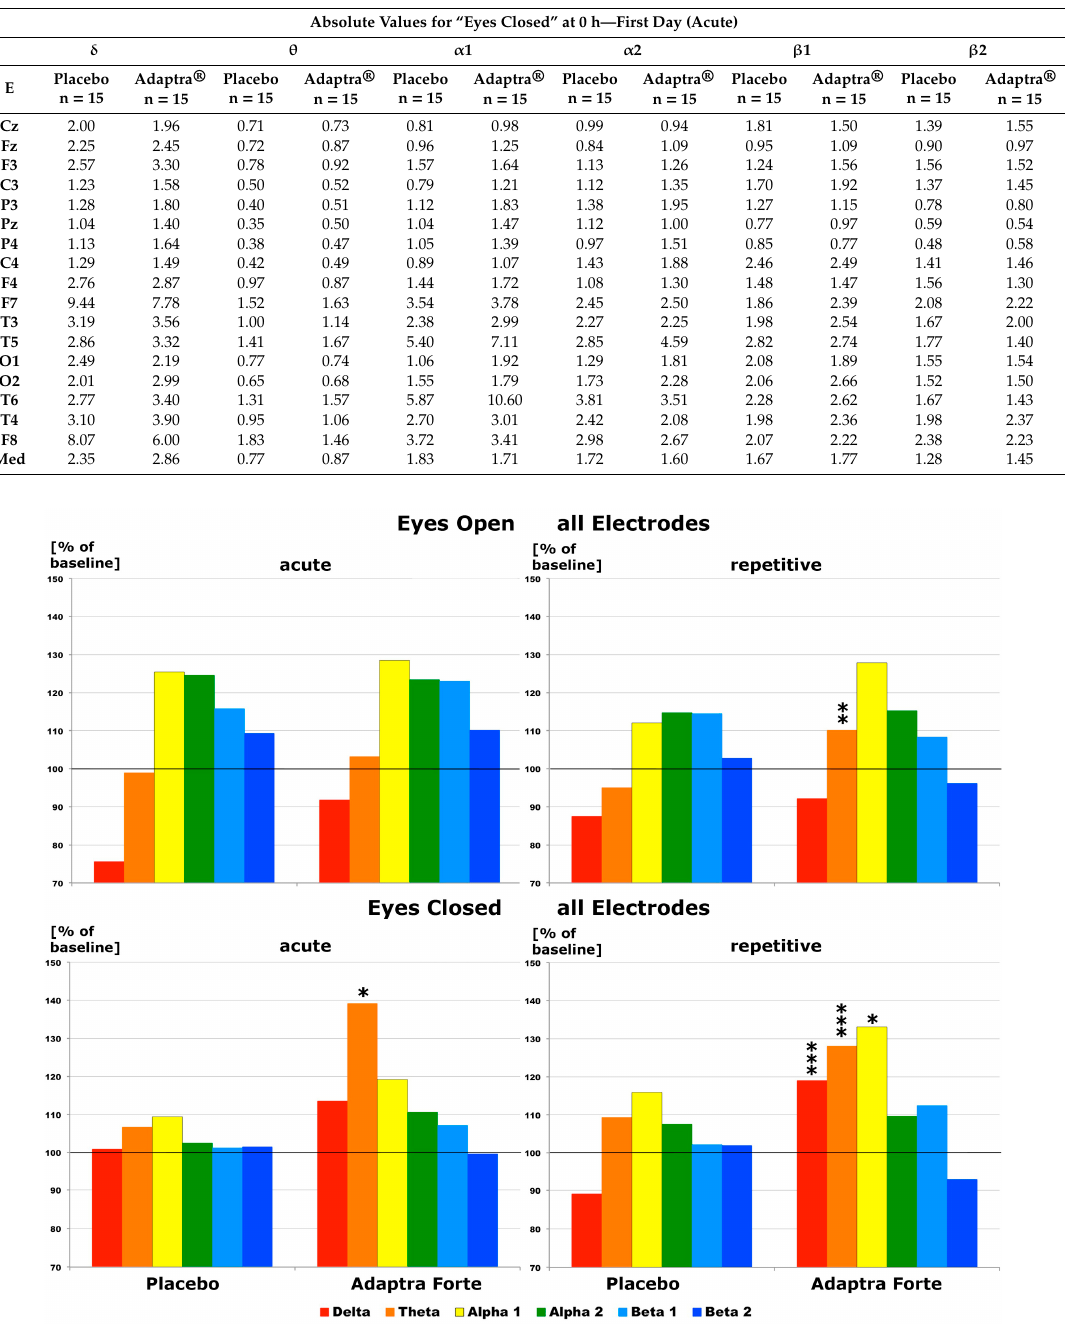
Table 3. Absolute spectral power of baseline as recorded with eyes closed. δ = delta, θ = theta, α 1 = alpha1, α 2 = alpha2, β 1 = beta1, β 2 = beta2 frequencies.